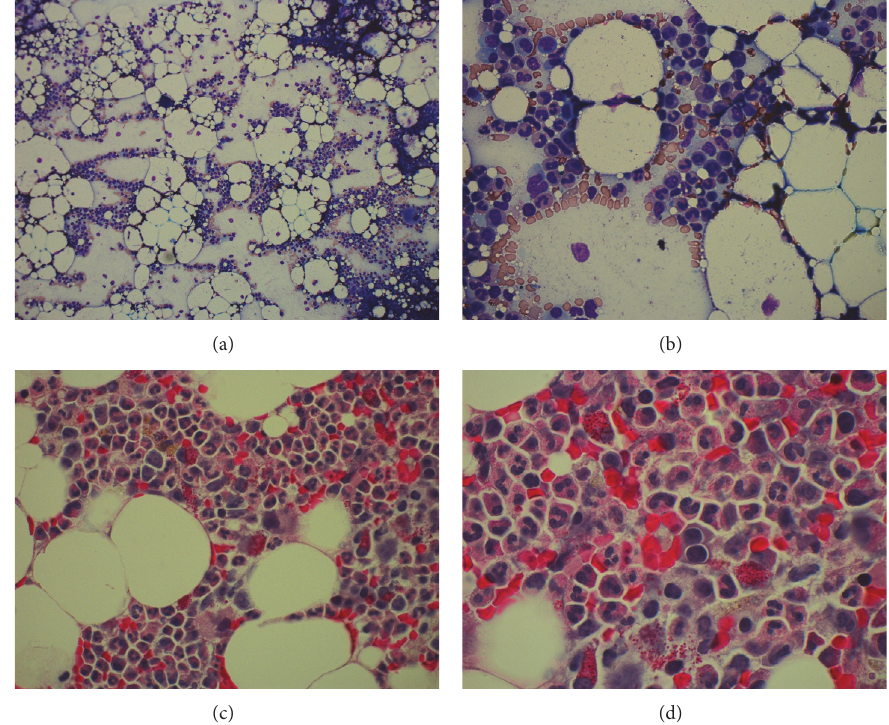
Figure 2: Engrafting bone marrow with trilineage hematopoiesis and decreased cellularity compared to previous marrow (30% versus 80%). (a) Bone marrow aspirate low power (10x), (b) bone marrow aspirate high power (60x), (c) bone marrow core biopsy (40x), and (d) bone marrow core biopsy (100x).